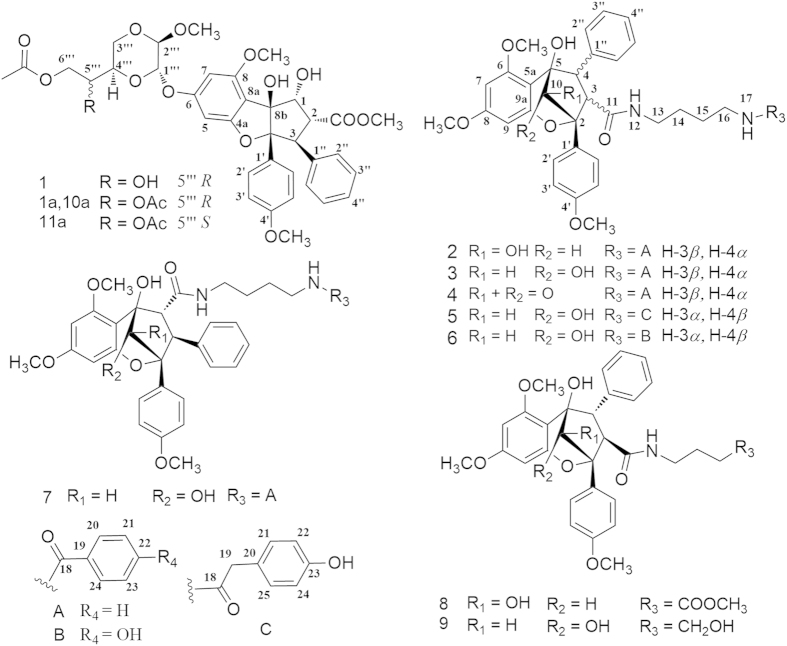
Chemical structures of compounds 1–9, 1a, 10a and 11a.